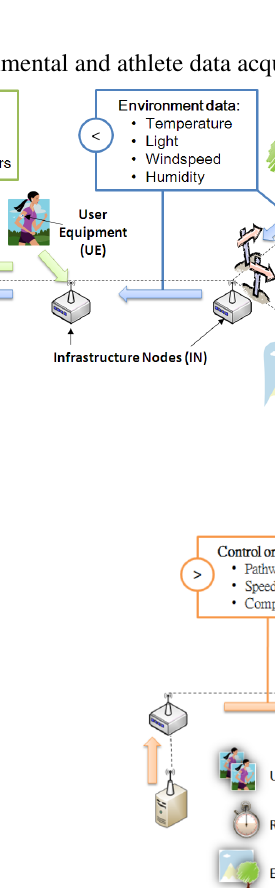
Figure 2. Data flow of the sensed data, the localization information, and the commands from the